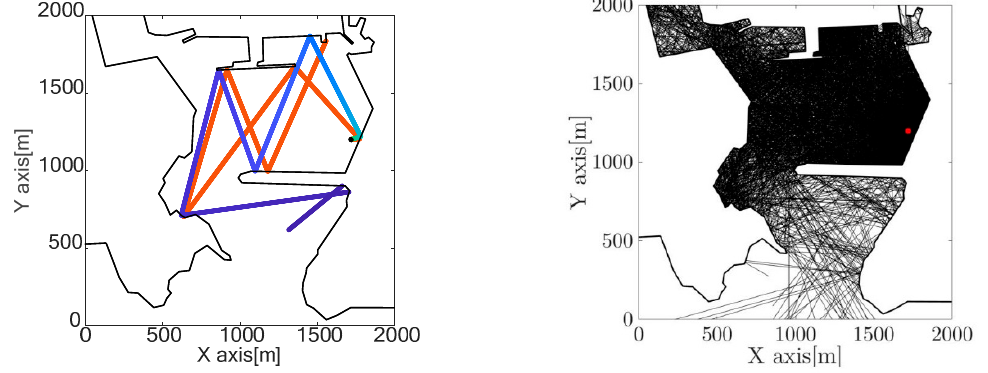
Figure 11. (left ) Example of two ray traces. ( right ) All the rays traced. The red dot indicates the source.